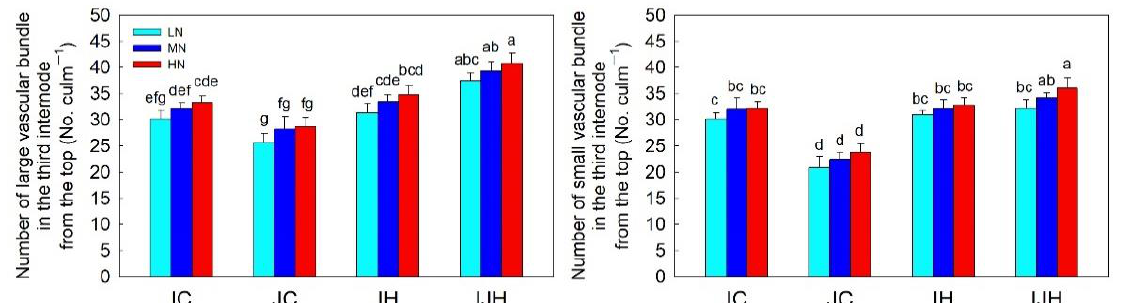
Figure 5. Numbers of large and small vascular bundles of the third internode from the top of different rice varieties under different nitrogen application levels. Different letters on top of histograms indicate significant differences at p < 0.05 among different rice varieties under different nitrogen application levels. IC, indica conventional rice; JC, japonica conventional rice; IH, indica hybrid rice; IJH, indica-japonica hybrid rice; LN, low nitrogen; MN, medium nitrogen; HN, high nitrogen.